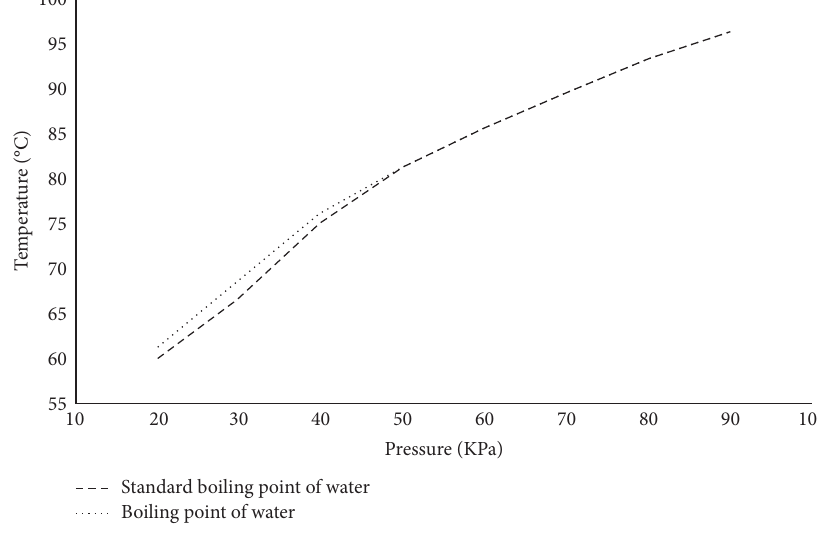
Figure 2: Pressure–boiling point diagram of water. Table 1: The concentration of COD and glycerol in the distillate.